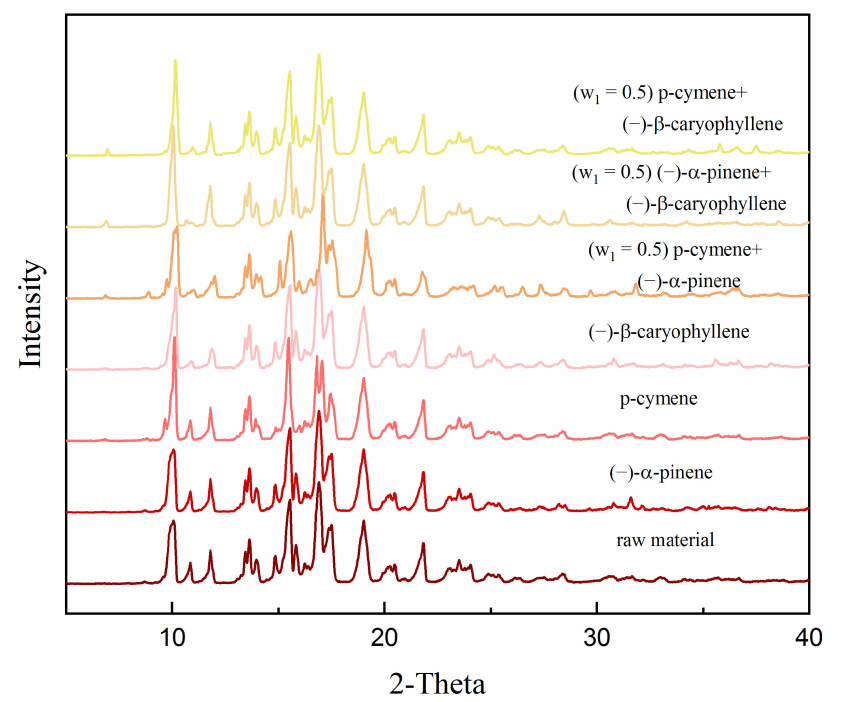
Figure 3. X-ray diffraction (XRD) patterns of raw dehydroabietic acid and recovered equilibrated dehydroabietic acid from three pure solvents and three binary mixed solvents.